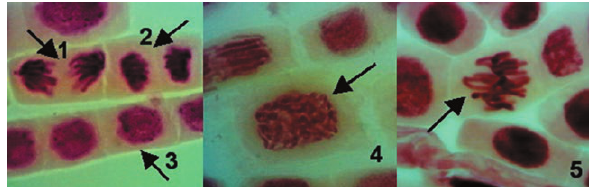
Figure 3. The mitotic phases are normal. 1) anaphase; 2) telophase; 3) interphase; 4) prophase; 5) metaphase.